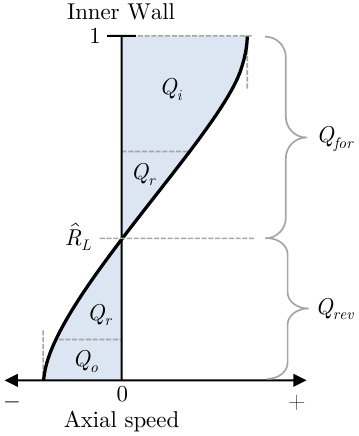
Figure 7. Radial symmetric illustration of the axial velocity profile Y ( ˆ r ) from the center axis to the inner wall of the hydrocyclone. Q for is a sum of Q i and Q r . Q rev is a sum of Q o and Q r